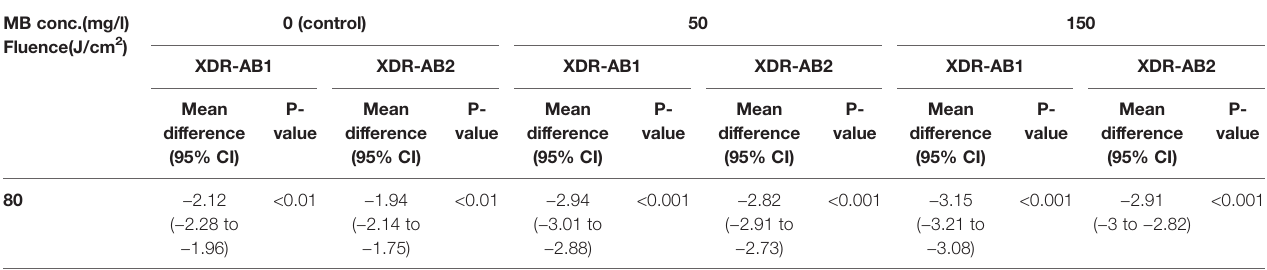
different pathogens. Many PSs possess unique properties. With